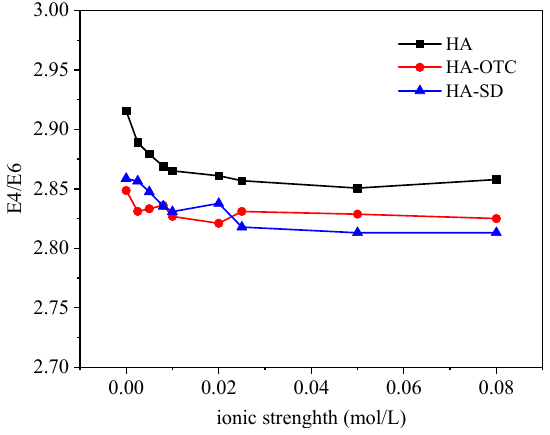
Figure 12. The E4/E6 of HA under different ionic strengths.